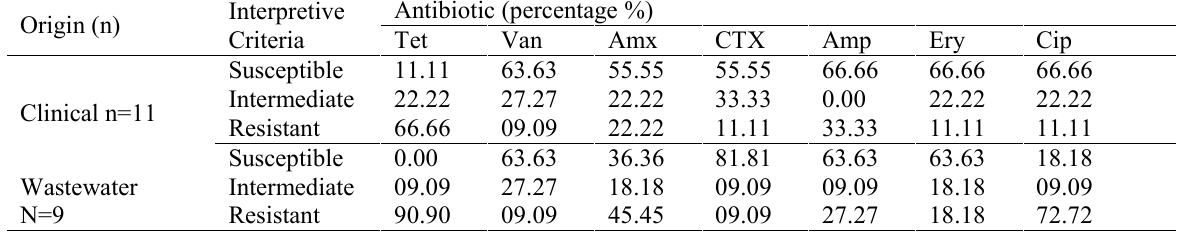
Table 1. Percentages of antibiotic resistance for the Enterococcal isolates from clinical and hospital wastewater samples Interpretive Origin (n)